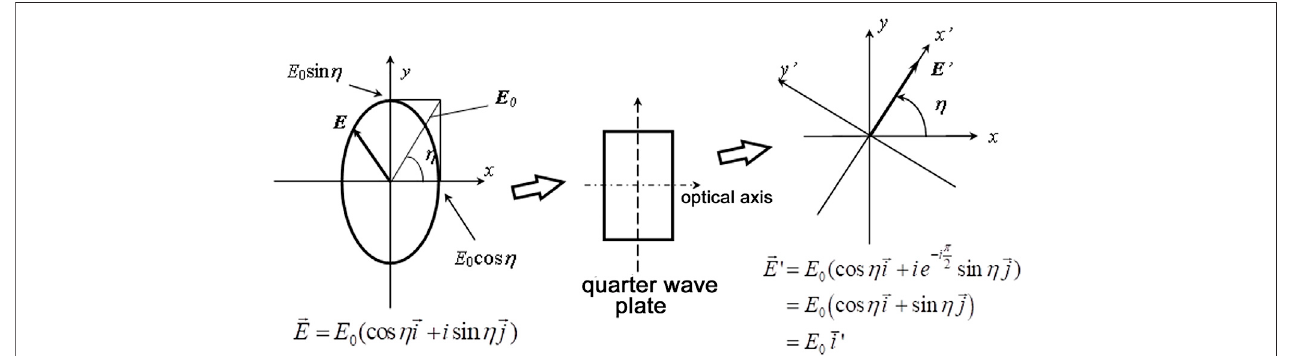
FIGURE 10 | Measurement of ellipticity using a quarter wave plate.